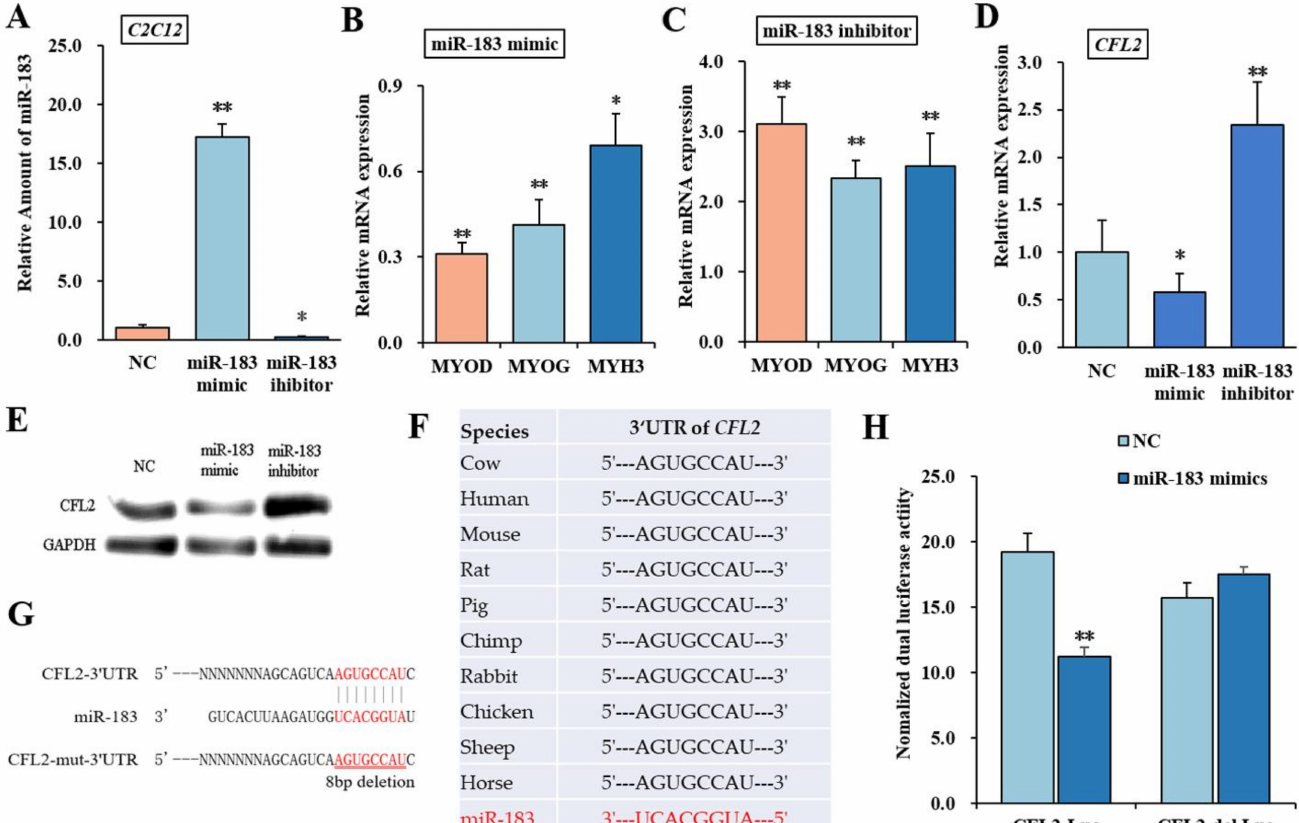
Figure 3. Bta-miR-183 target muscle type CFL2. Expression efficiency of miR-183 was examined after treating bta-miR-183 mimic and inhibitor for 48 h in C2C12 cells ( A ). The expression of myoblast differentiation marker genes MYOD , MYOG , and MYH3 were detected by qRT-PCR after transfecting miR-183 mimic or inhibitor into C2C12 cells and inducing for 4 d with 2% horse serum ( B , C ). The expression level of miR-183 was normalized to U6, the mRNA levels of CFL2 and three marker genes were normalized to GAPDH . CFL2 mRNA ( D ) and protein ( E ) expression in PBMs were detected by qRT-PCR and Western blot after being transfected with miR-183 mimic, miR-183 inhibitor and NC for 48 h. Putative binding sites of miR-183 on the 3 (cid:48) UTR fragments of CFL2 mRNA were detected in different species ( F ). Computational prediction of the targeting sites of miR-183 on the 3 (cid:48) UTR fragments of CFL2 was conducted in Bos Taurus, and 8 base deletion of CFL2 3 (cid:48) UTR was designed for mutant type ( G ). PBMs co-transfected with pairwise plasmids (bta-miR-183 mimic and CFL2-Luc, NC and CFL2-Luc, bta-miR-183 mimic and CFL2-del Luc, NC and CFL2-del Luc), and Renilla luciferase activity was normalized to the firefly luciferase activity ( H ). NC, Negative Control. Mean data ± SE of n = 3 independent experiments, each performed in triplicate. * p < 0.05 and ** p <